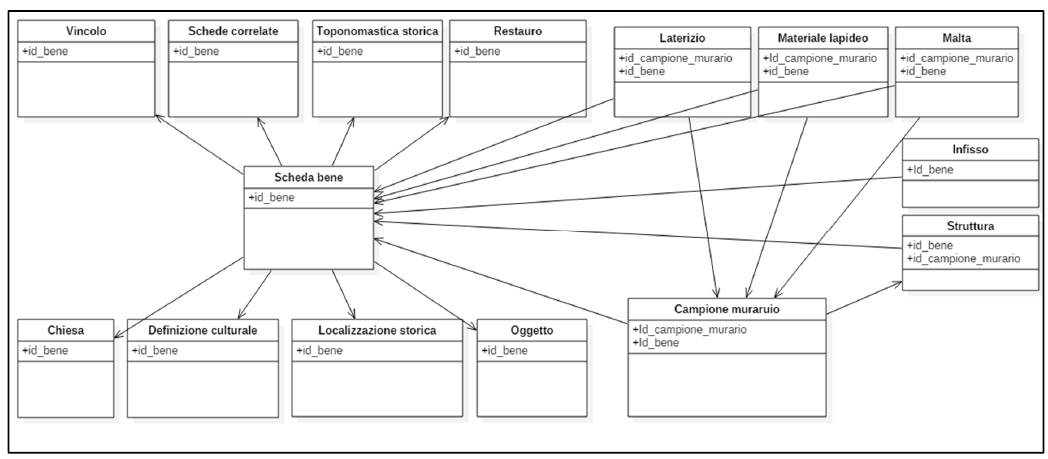
Figure 2. Geodatabase Structure.